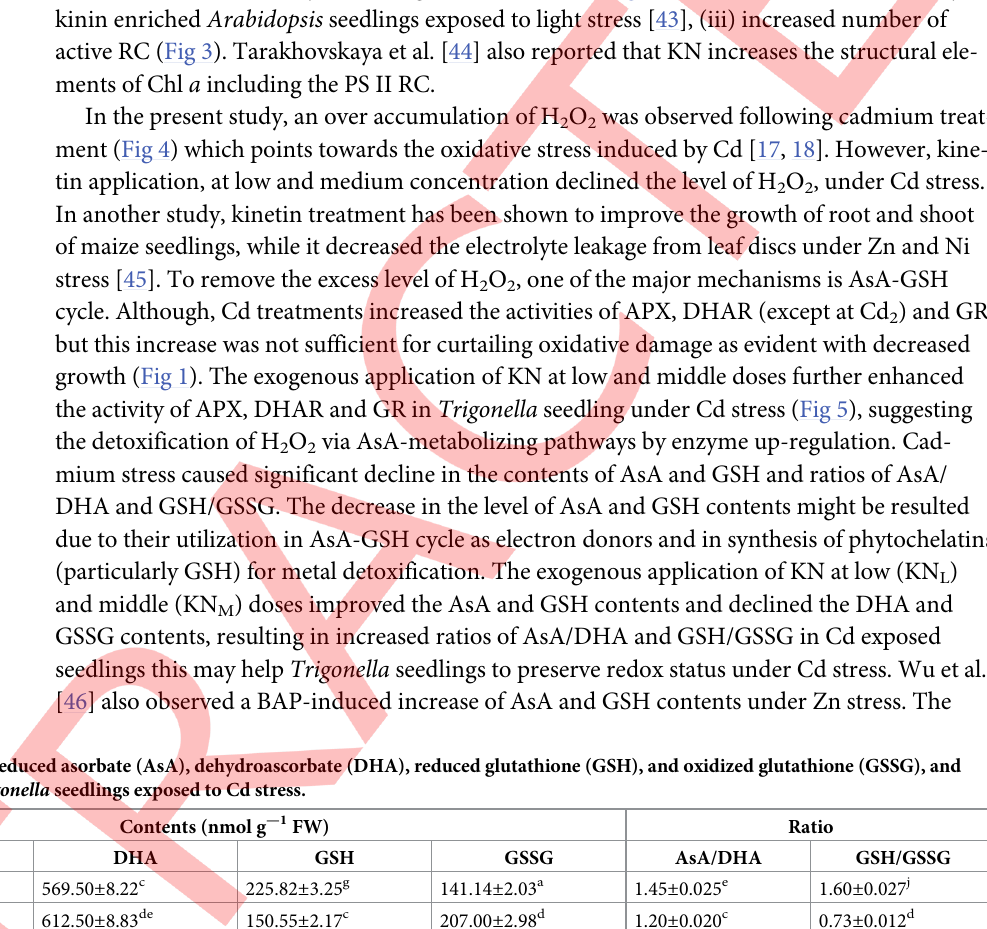
Fig 5. Impact of foliar application of KN on ascorbate peroxidase, dehydroascorbate reductase and glutathione reductase activities of Trigonella seedlings exposed to Cd stress. Data represent the mean value ± standard error from three replicates (n = 3). Values followed by the different letters at each bar differ at P < 0.05 among treatments by the DMRT.